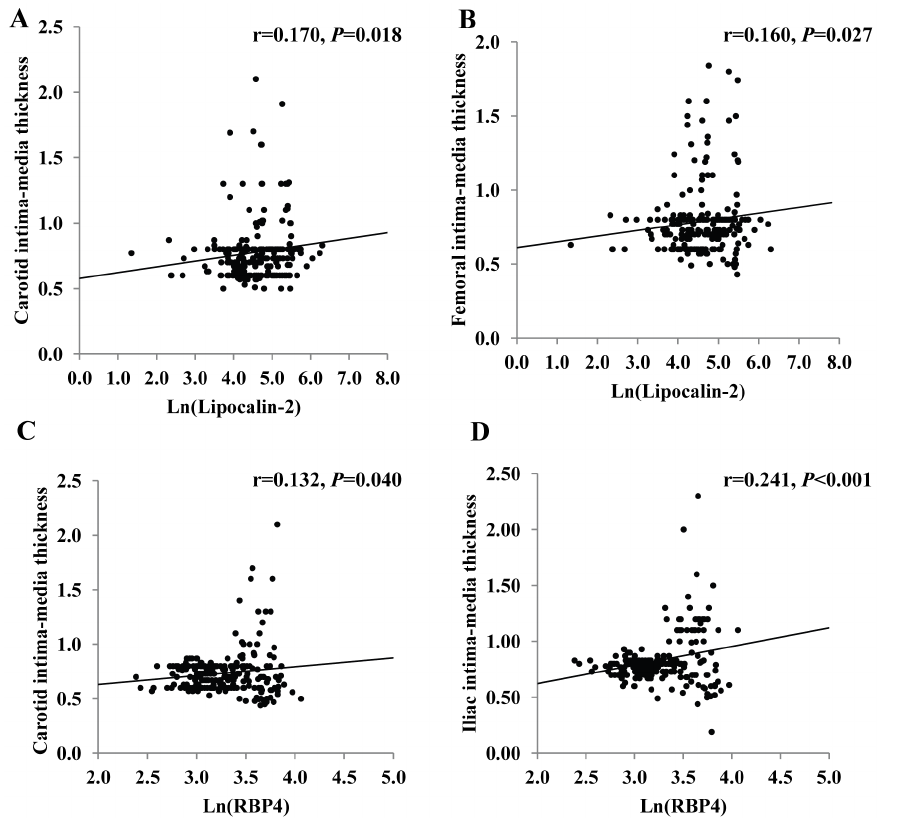
Figure 1. Correlations between lipocalins and IMTs. Correlations between serum Lipocalin-2 and (A) carotid IMT (n=225) or (B) femoral IMT (n=223) in type 2 diabetic patients; correlations between serum RBP4 and (C) carotid IMT (n=244) or (D) iliac IMT (n=242) in type 2 diabetic patients. Ln, natural logarithm.